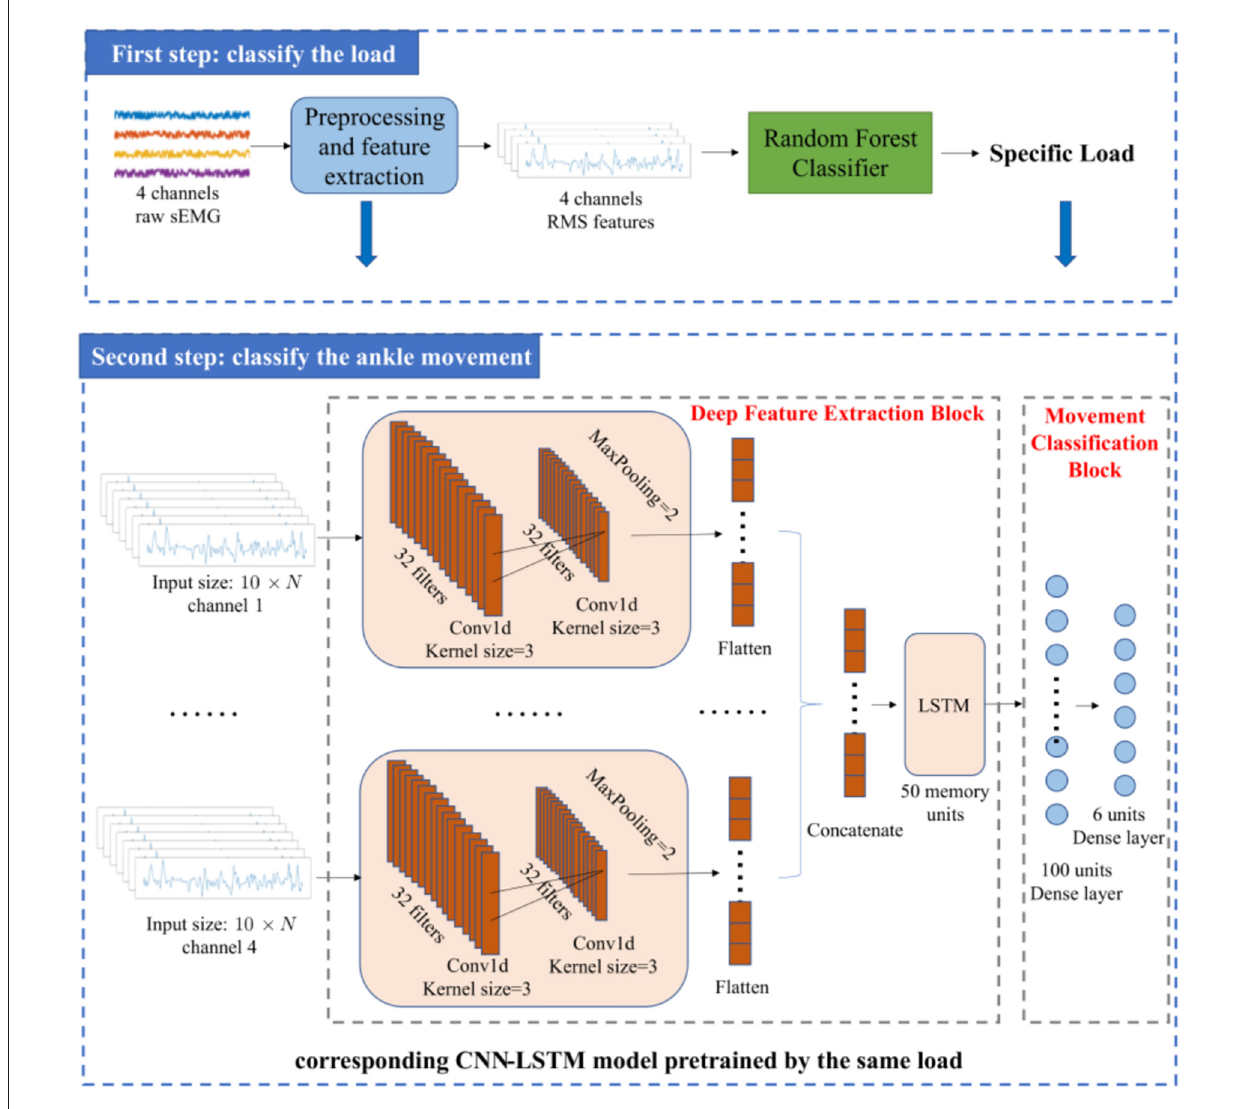
FIGURE1 Framework of the ankle movement classification